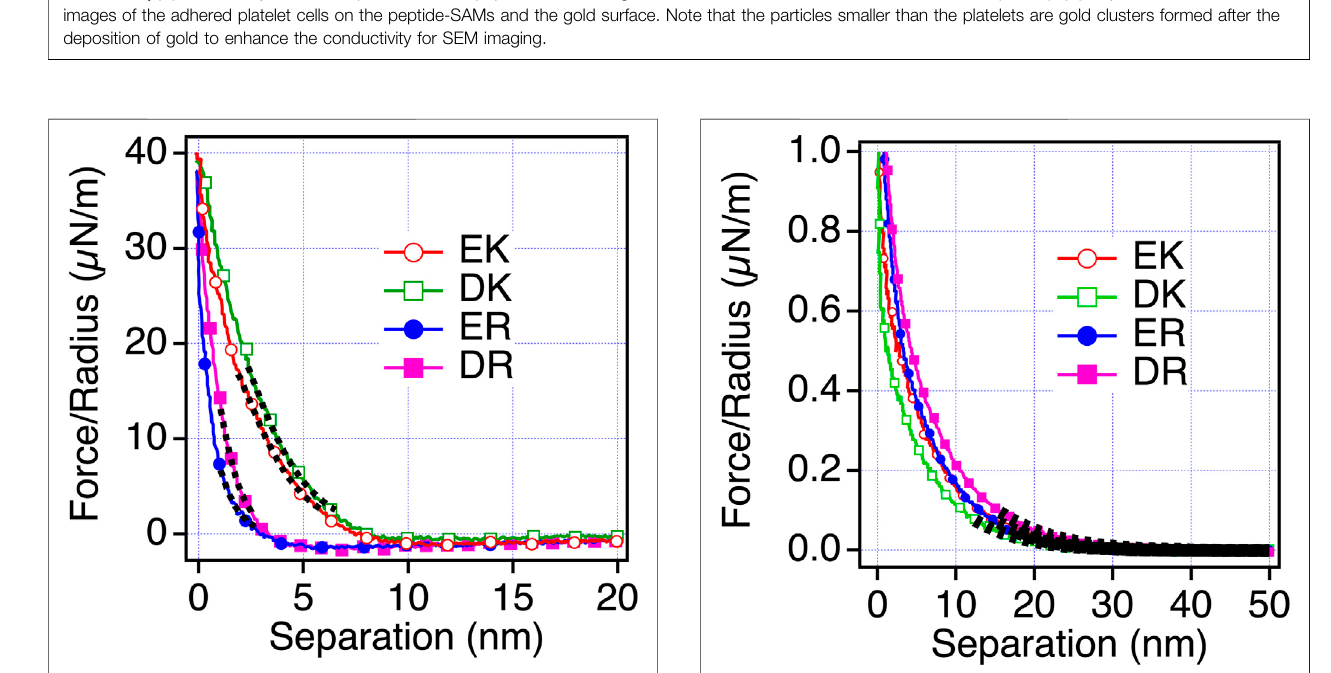
The Δ d / Δ f values also provide insight into the mechanical properties of the protein layer formed on the peptide-SAMs ( Table 3 ). The Δ d / Δ f values for protein-resistant EK and DK are higher than those for protein-adsorbing ER and DR SAMs ( Table 3 ). These results indicate that the interaction of fi brinogen with ER and DR SAMs is stronger than that with EK and DK SAMs and/or the formed protein layer is highly viscoelastic because of the denaturation of the protein molecules after adsorption.